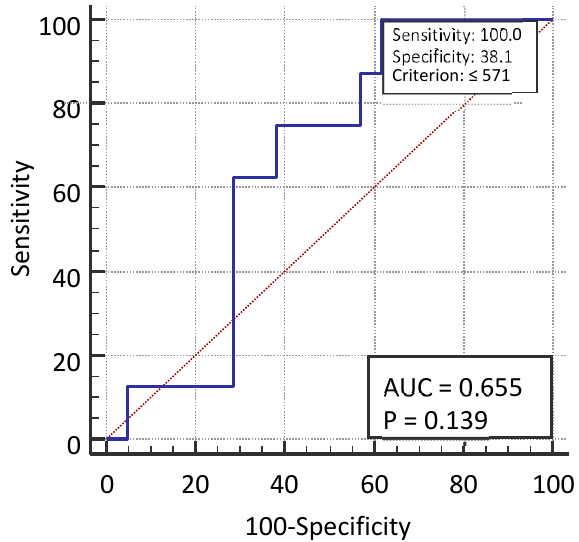
Figure 2. Median follow-up of patients from diagnosis to disease progression.